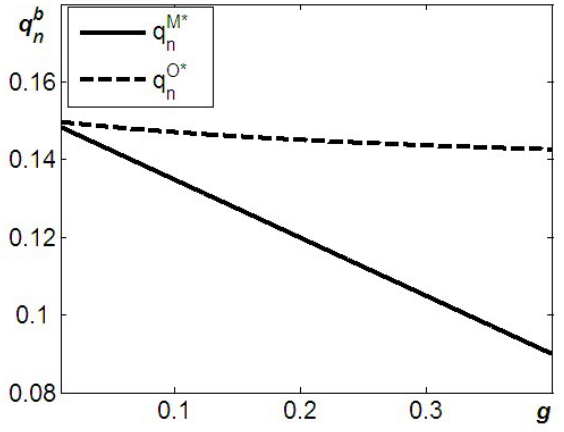
Figure 2. Effect of g on q b n